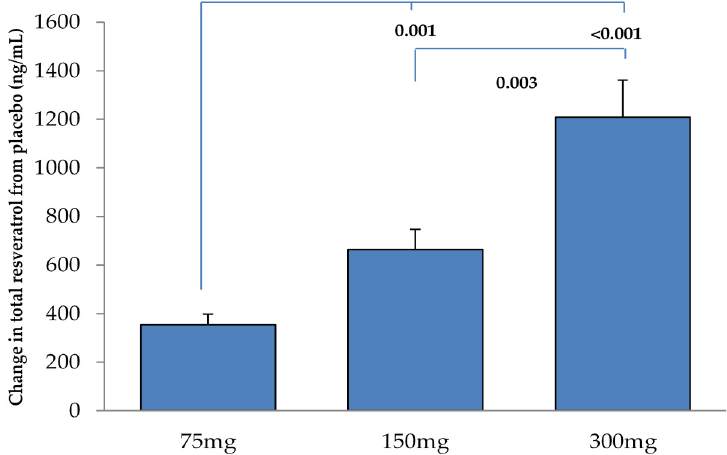
Figure 2. Changes in total plasma resveratrol concentrations with each dose of resveratrol compared to placebo. Data are mean ± SEM.